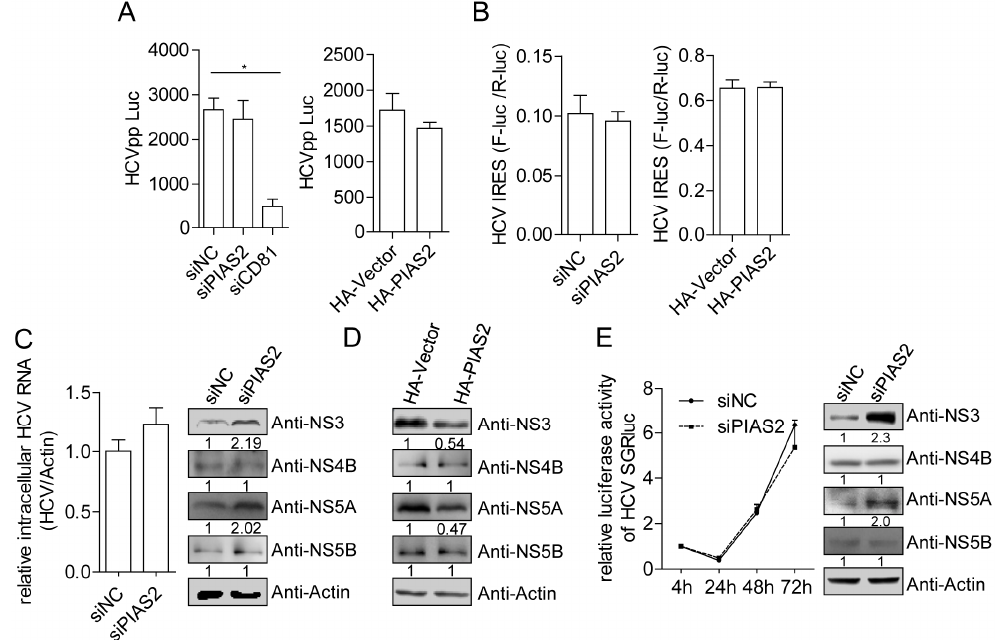
Figure 3. PIAS2 restricts HCV protein expression in the subgenomic replicon. ( A ) Huh7 cells were transfected with siRNA or plasmids as indicated for 48 h and then transduced with HCVpp. The luciferase activity was measured 48 h post-transduction; ( B ) Huh7 cells were transfected with the siRNA or plasmids as indicated and then transfected with the pHCV-internal ribosome entry site (IRES) reporter plasmid. The dual-luciferase assay was performed 48 h later. The IRES translation efficiency was determined by the ratio of firefly luciferase (F-Luc) activity to Renilla luciferase (R-Luc) activity; ( C ) Con1 cells were transfected with the indicated siRNAs. The HCV RNA and protein expression levels were detected at 72 h post-transfection. The numbers below each blot show the relative density of the blots normalized to actin; ( D ) Con1 cells were transfected with vector or pHA-PIAS2 plasmids and HCV NS3, NS4B, NS5A and NS5B protein expression were detected by western blotting; ( E ) Huh7 cells were electroporated with the JFH1-SGR-luc RNA (10 μ g) together with the siNC or siPIAS2 (20 nM). Luciferase activity was measured at the indicated time points and normalized to the value obtained at 4 h post-electroporation. The HCV protein expression levels were detected at 72 h, * p < 0.05.